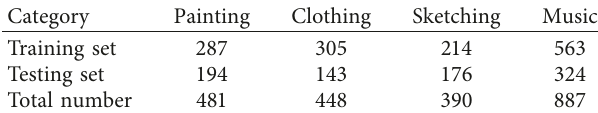
Table 1: Experimental data of digital art design.